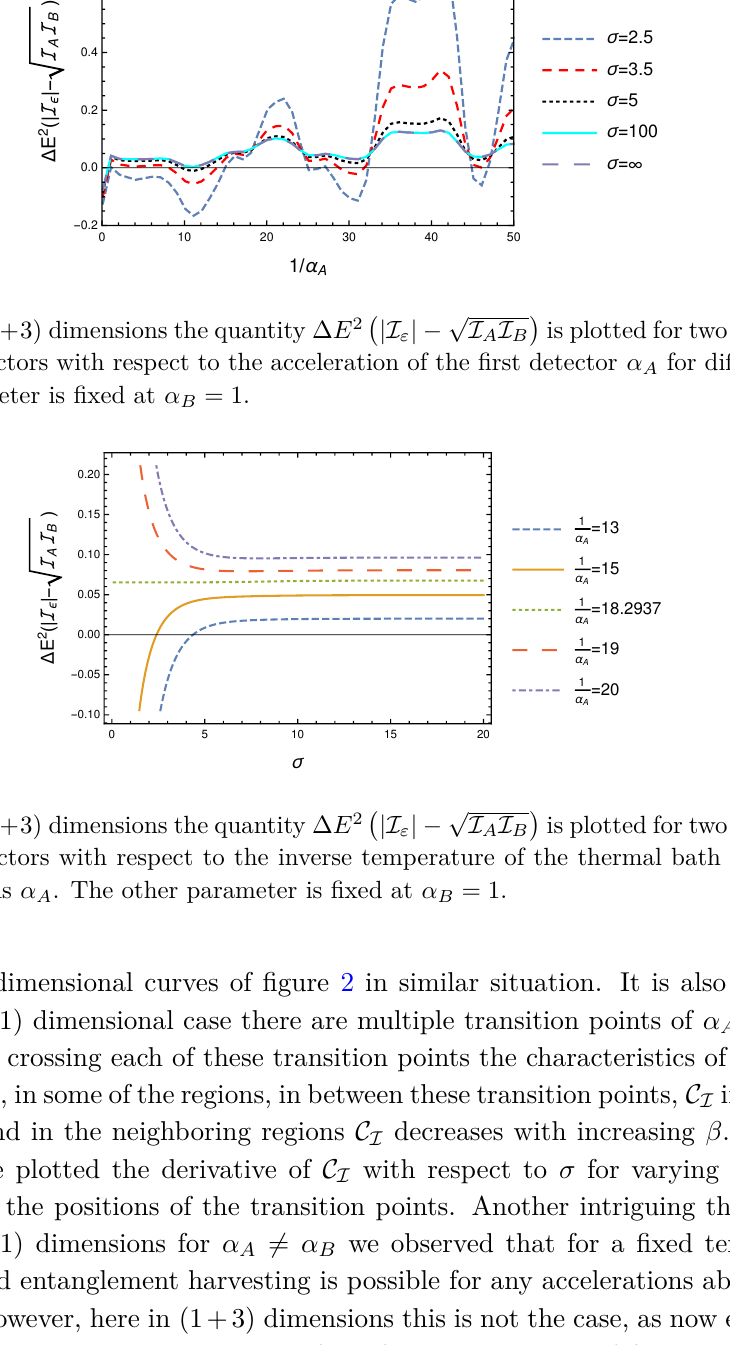
Figure 10 . In (1+3) dimensions the quantity ∆ E 2 accelerating detectors with respect to the acceleration of the first detector α The other parameter is fixed at α